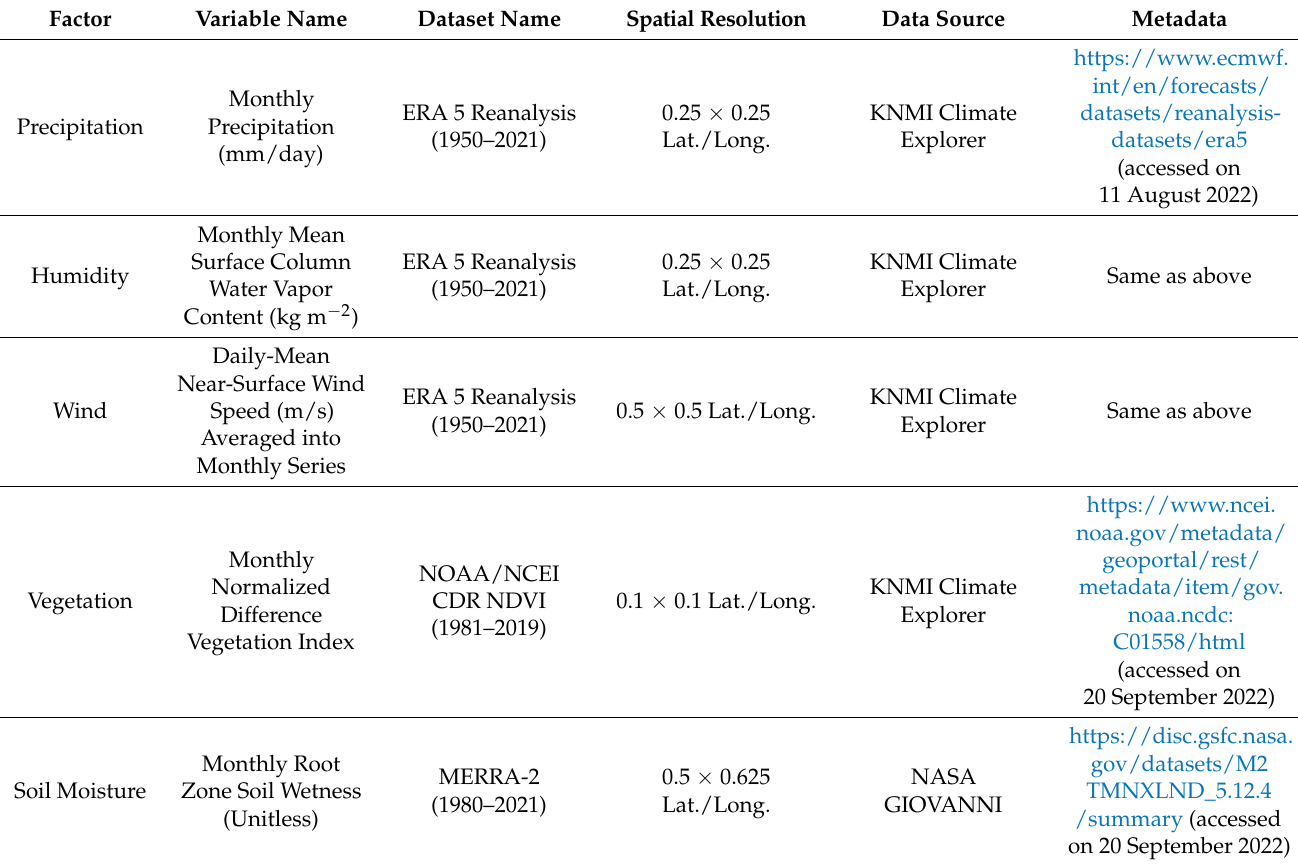
Table 1. Datasets used in this study to represent major factors of dust